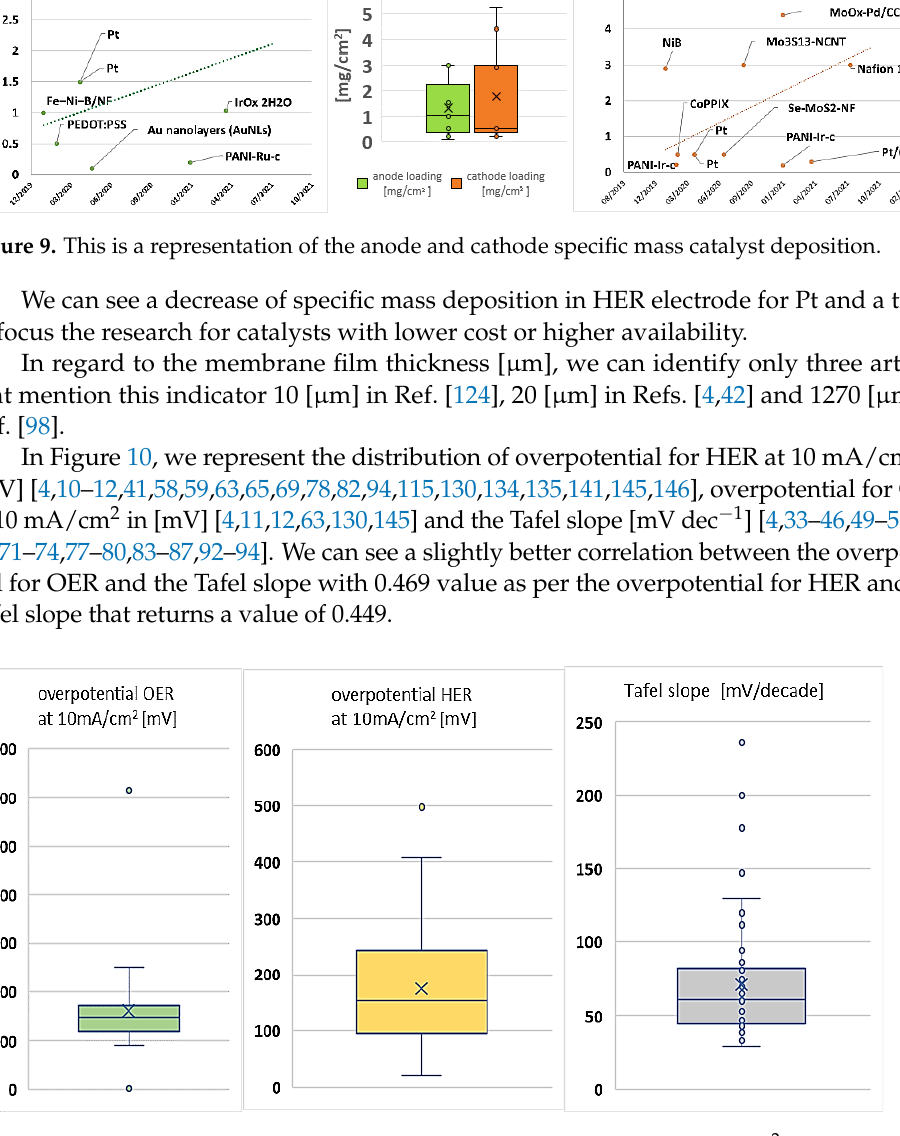
Figure 10. BW charts representing overpotential for HER and OER at 10 mA/cm 2 in [mV], and the Tafel slope [mV dec −1 ].